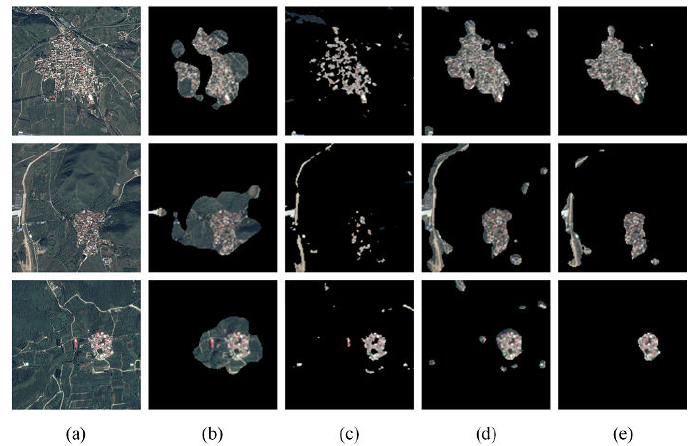
Figure 2. Region-of-interest (ROI) detection results produced by our model and the other 3 models. ( a ) origin images; ( b ) ITTI; ( c ) FT; ( d ) frequency domain analysis (FDA) and ( e ) our model.